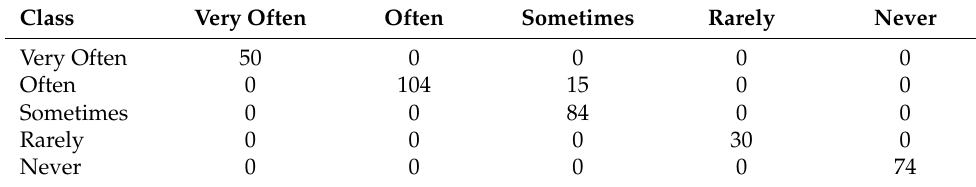
Table 8. Confusion matrix of stratified cross validation.